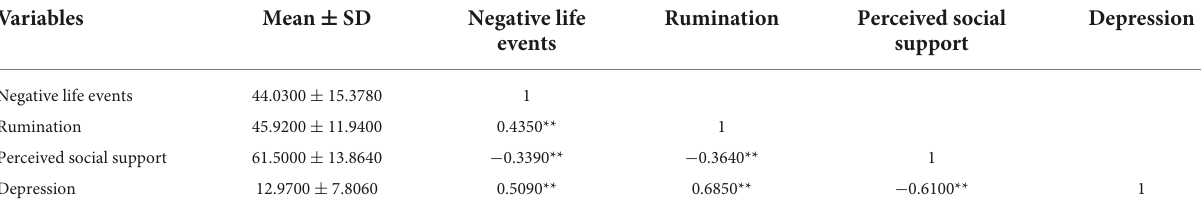
TABLE 1 Descriptive statistics of each variable and the correlation analysis results ( N = 493) ** p < 0.01.